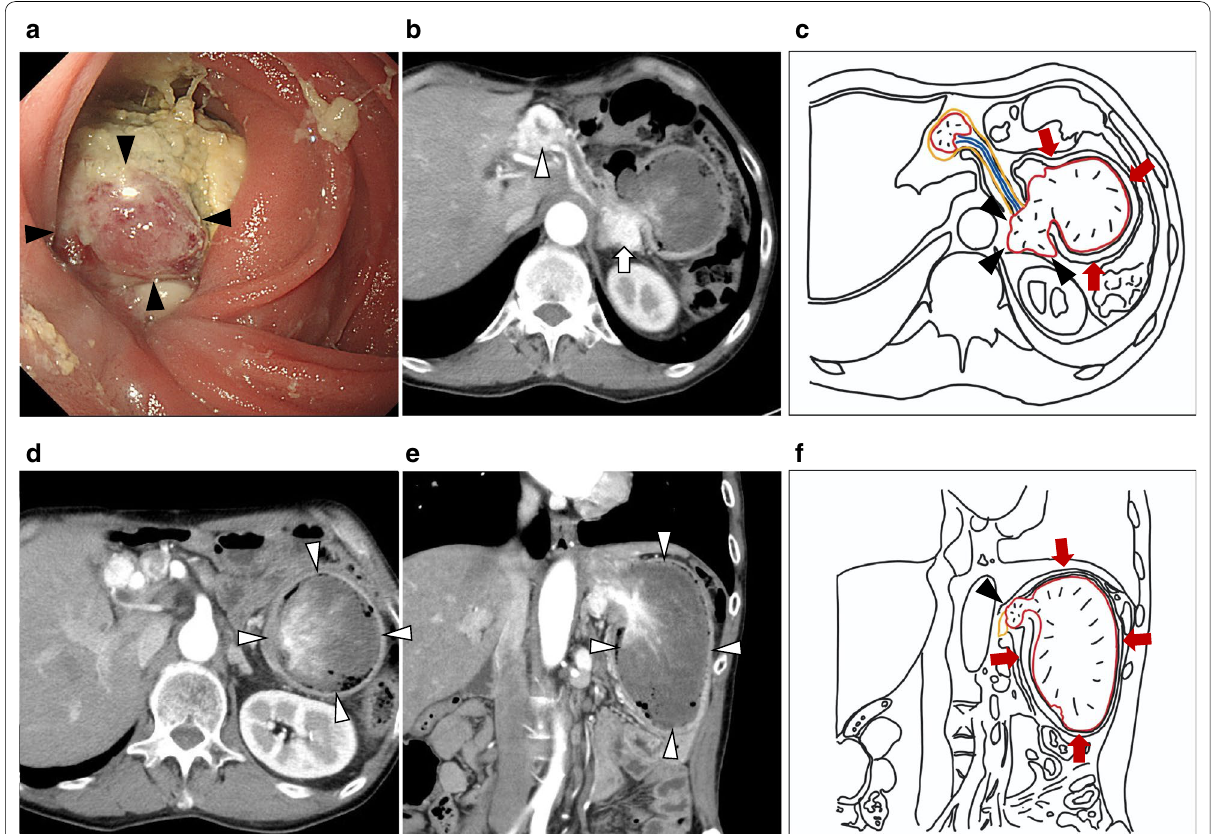
Fig. 1 Esophagogastroduodenoscopy (EDGS) images and abdominal CT findings. a EDGS detected a massive tumor with necrotic tissue (arrowhead) in the jejunal limb occupying the lumen. b , d , e Images in the arterial phase of CT. b Hypervascular tumors can be seen in pancreatic head (arrowhead) and tail (arrow), and the massive tumor in the pancreatic tail can be seen extending into the jejunal limb. c A schema of b . The tumor in the pancreatic tail (arrowhead) invaded the wall of the jejunal limb and expanded into lumen of the jejunal limb (arrow). d , e The jejunal limb was enlarged and filled by the tumor thrombus (arrowhead). f A schema of e . The tumor in the pancreatic tail (arrowhead) invaded the wall of the jejunal limb and caused tumor thrombus filling the lumen of the jejunal limb